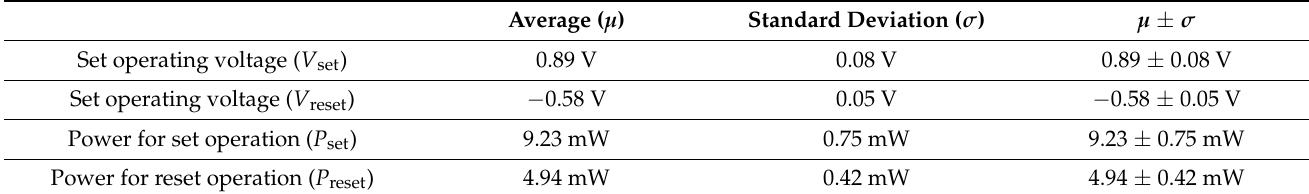
Table 1. Total operating parameters of solid polymer electrolyte (SPE)-chitosan memristor.